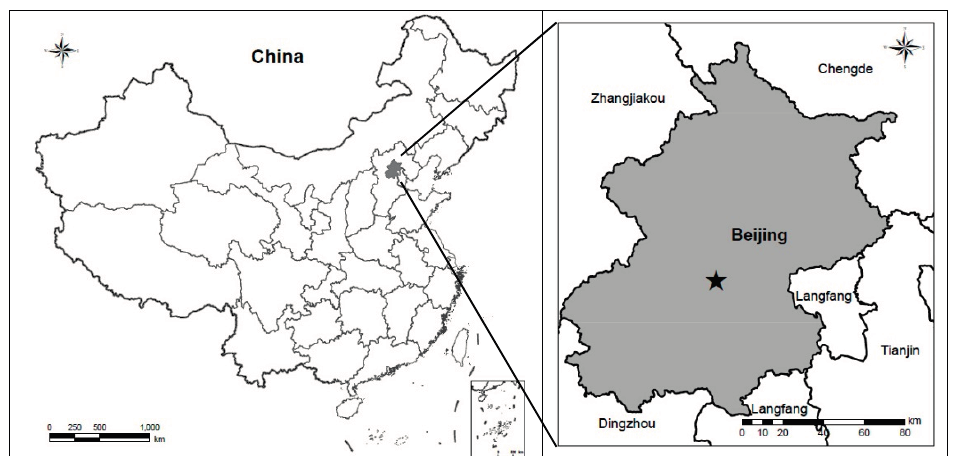
Figure 1. Study area: Beijing,